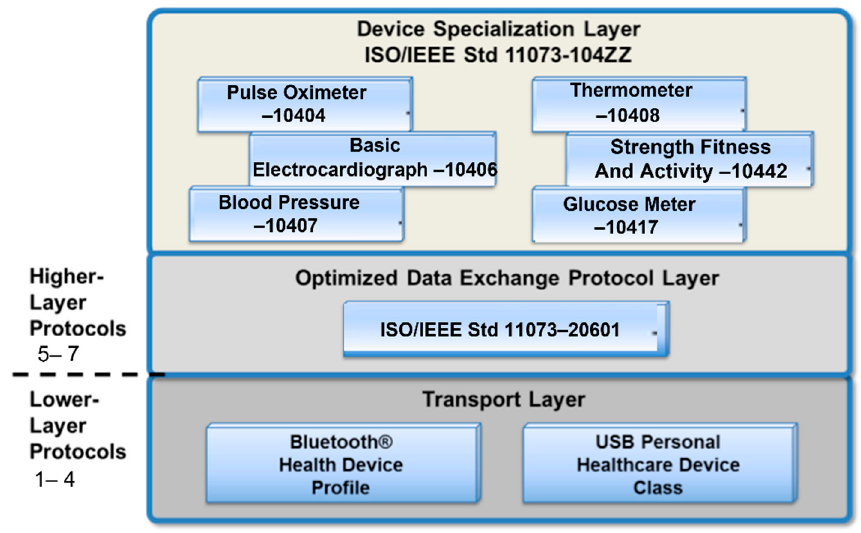
Figure 1. Organization and dependencies of the protocols established by the Continua Health Alliance, over the Open Systems Interconnection (OSI) model.